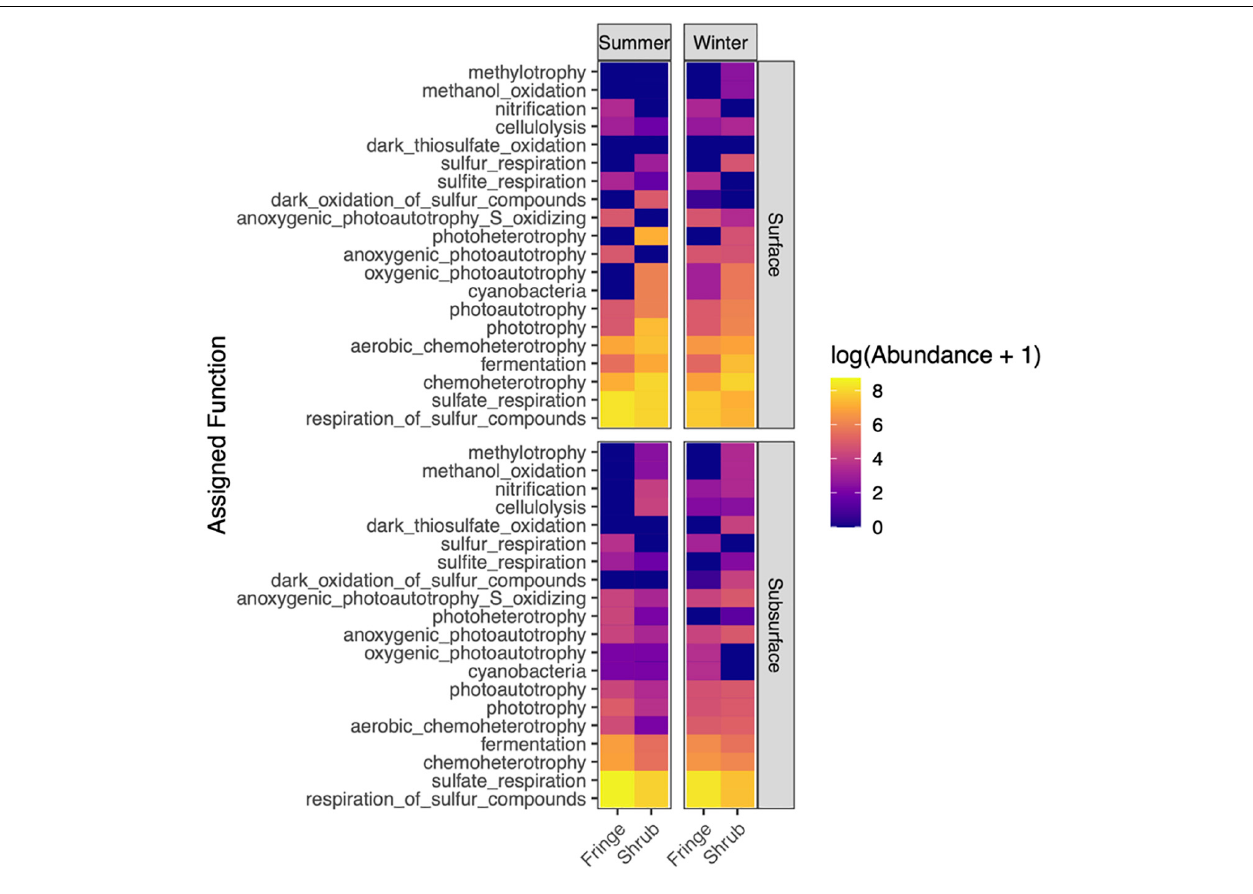
FIGURE 10 | Heat map showing the distributions of bacterial functions that were assigned by FAPROTAX across season, zone and depth. Values were log-transformed with lighter values indicating higher abundances. For readability, only the top 20 most prevalent functions are